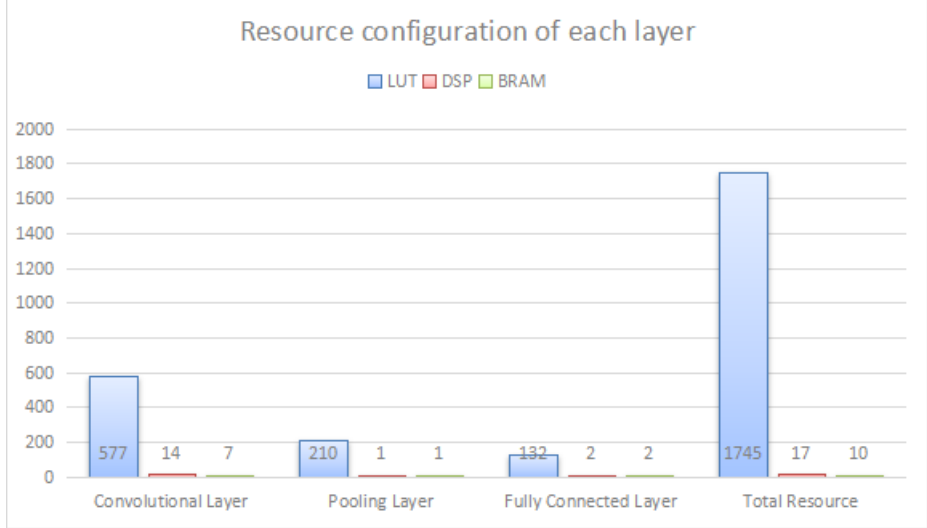
Figure 15. Resource configuration of each